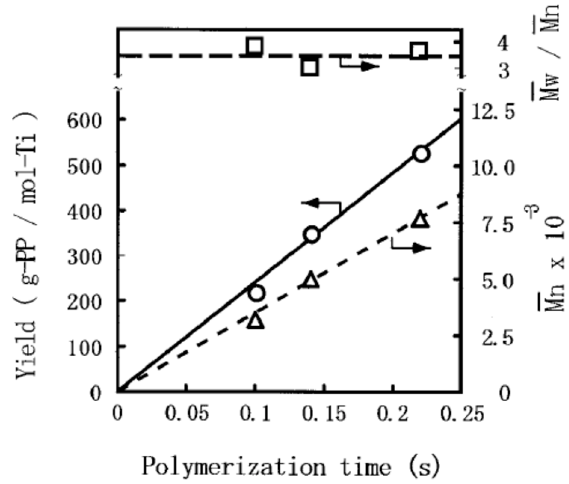
Figure 2. Yield, M n and M w / M n development in SF propylene polymerization using a TiCl 4 /ethylbenzoate/MgCl 2 -based catalyst [22].